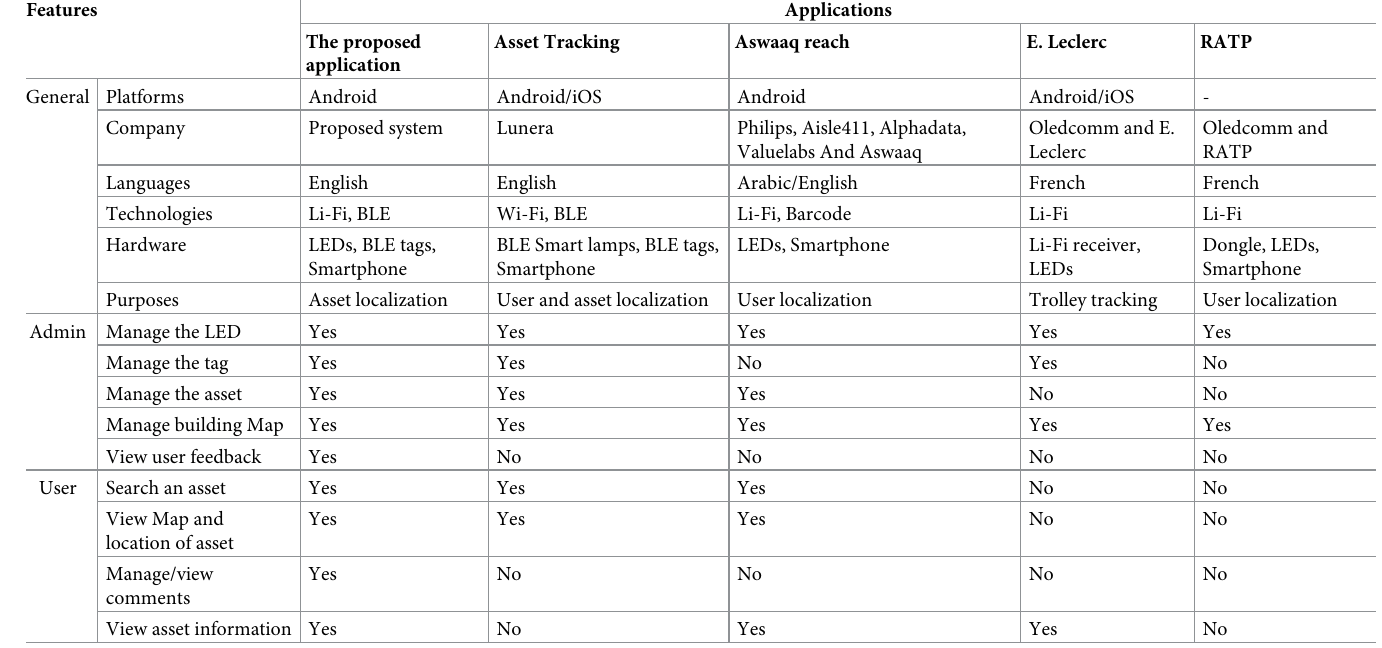
Table 1. Comparisons among similar